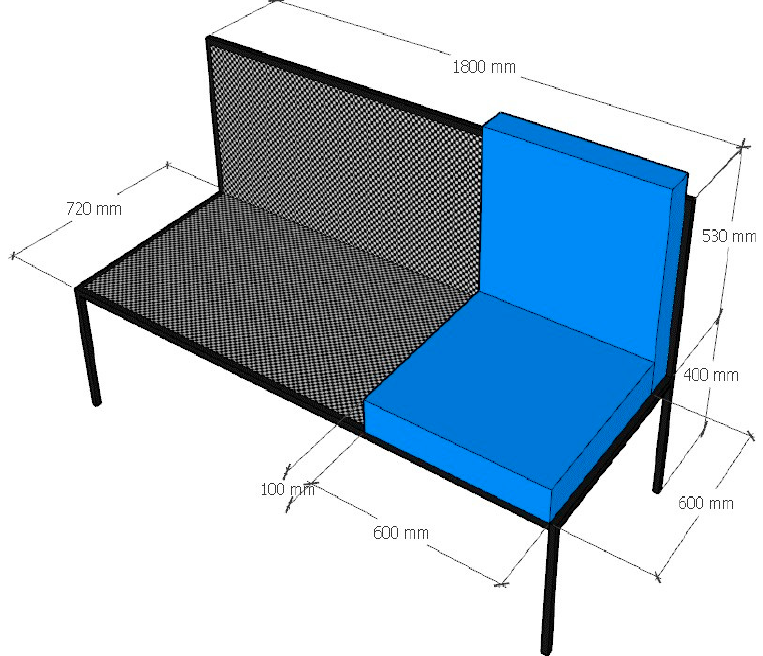
Figure 2. Sofa model used in fire testing.